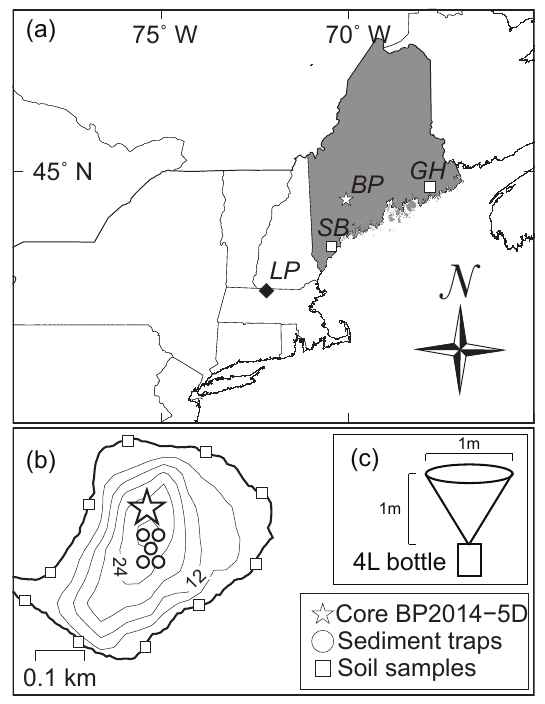
Figure 1. Map of Basin Pond. (a) The location of Basin Pond (BP) (white star) in Maine, USA. Locations of three other sites are la- beled: Little Pond (LP; Gao et al., 2017), Great Heath Lake (GH; Nichols and Huang, 2012; Clifford and Booth, 2013), and Saco Bog (SB; Clifford and Booth, 2013). (b) Bathymetric profile (6m con- tours) of Basin Pond with position of floating sediment traps (cir- cles), surface soil samples (squares), and core BD-2014-5D used for the down-core temperature reconstruction in this study (star). The pond has an area of approximately 0.14km 2 . (c) Schematic of sediment traps utilized in this